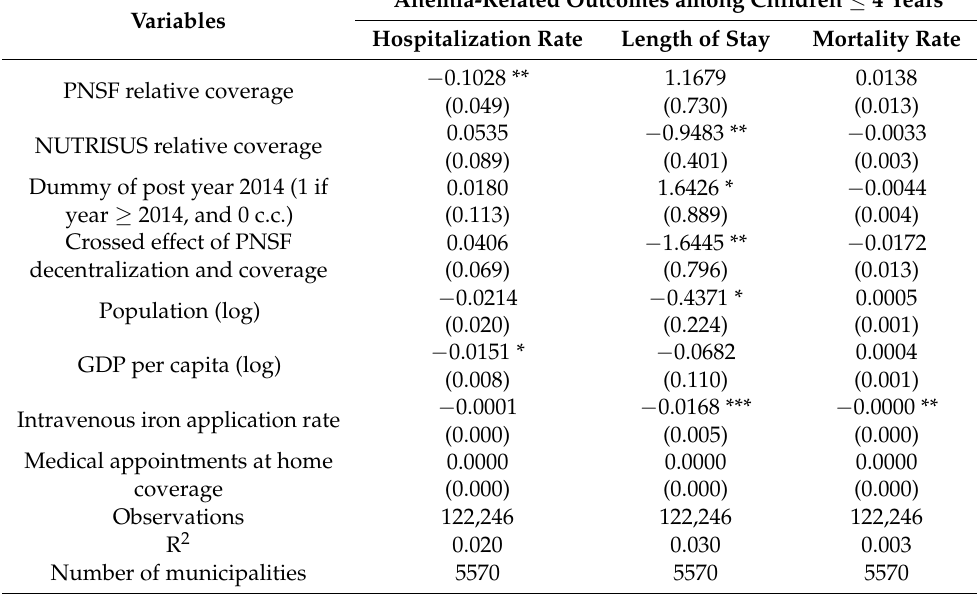
Table 4. Coefficients of the DD–FE estimates on the effects of the PNSF and NutriSUS on anemia- related outcomes among children, Brazil,